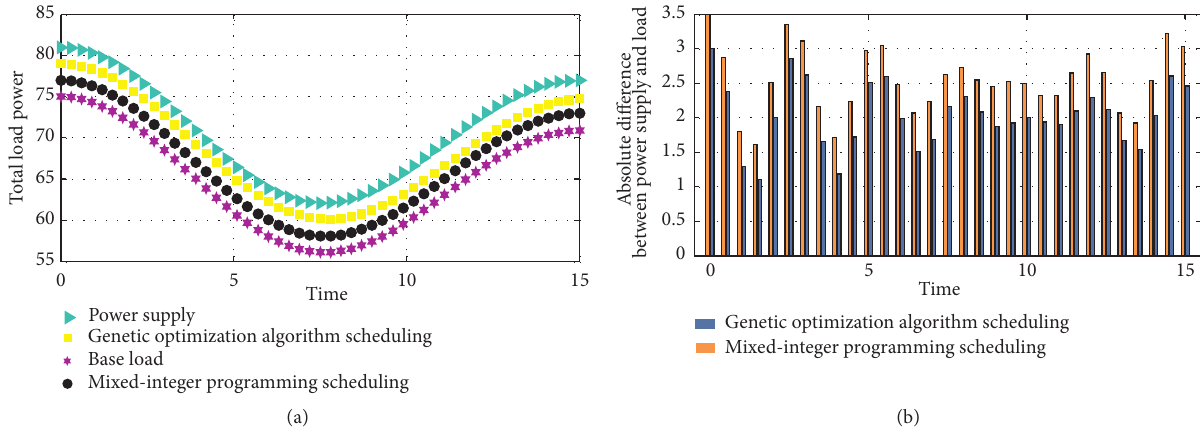
Figure 9: Comparison of two algorithms at t � 12 in real-time distributed system. (a) Load power curve. (b) Comparison of absolute difference between power supply and